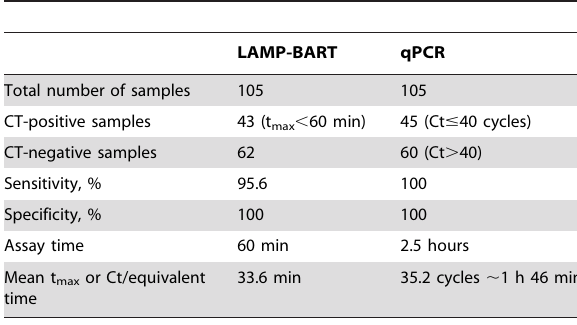
Figure 6. Devices for BART assays and different formats of BART data output. (A) Original laboratory set-up for BART used in the research presented in this paper. (B–D) Later designs of custom equipment for BART assays. High-throughput CCD-camera based system for laboratory use available in 96/384-well format. (B) Exploded diagram and picture (C) of the CCD-camera-based device: 1 – light box, 2 – CCD-camera, 3- samples in standard 0.2 ml PCR tubes or 8-well strips or 96-well plate, 4 – heating block. (D) Portable diode-based device for one or two 8-well strips. (E) Graphical representation of the data for a dilution series: red – 1 ng, orange – 100 pg, green – 10 pg, blue – 1 pg, black - NTC. (F) Corresponding images of LAMP-BART reactions taken at 10 (a), 21 (b), 24 (c), 25 (d), 26 (e) and 30 min (f): top row – ChAT DNA dilution series with the decreasing amount of template 1 ng, 100 pg, 10 pg, 1 pg (left to right); bottom row – no-template control. doi:10.1371/journal.pone.0014155.g006 Table 1. Results of Chlamydia trachomatis testing by LAMP-BART and